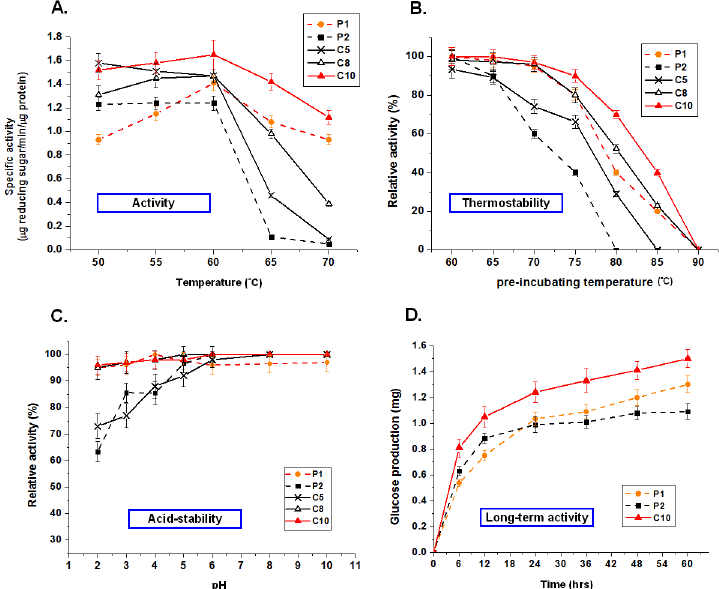
Fig 3. Characterization of GH5 chimeras. (A) Activity profiles of GH5 parents and chimeras at high temperatures. (B) Residual activities (thermostability) of GH5 parents and chimeras after heat-treatment. One microgram of purified cellulases was pre-incubated in 50 mM sodium acetate buffer (pH 5.0) at different temperatures for 10 min. The residual enzyme activities were then determined on 1% PASC at pH 5.0 at their optimal temperature for 6 hrs. Relative activities were compared with the optimal activity of each enzyme without a pre-incubating treatment at 60°C. Some of the enzymes, e.g. C5, do not have the initial point (60°C) of 100% because their optimal activities are not at this reaction temperature and therefore have a slightly lower staring points in the analyses with 60°C pre-incubation temperature. (C) Acid stability of the parents and chosen chimeras. One microgram of purified cellulases was pre-incubated in 50 mM buffer with variable pH for 12 hrs. The residual enzyme activity was determined. Relative activities were compared with the optimal activity of each enzyme without a pre-incubating treatment at pH 5. (D) Long-term activity of the most stable chimera C10 compared with its parents in PASC hydrolysis. One microgram of purified cellulases plus 0.5 μ g Novo-188 ( β -glucosidase, Novozyme) was added into 1% PASC at 50°C, pH 5.0 for 6, 12, 24, 36, 48, and 60